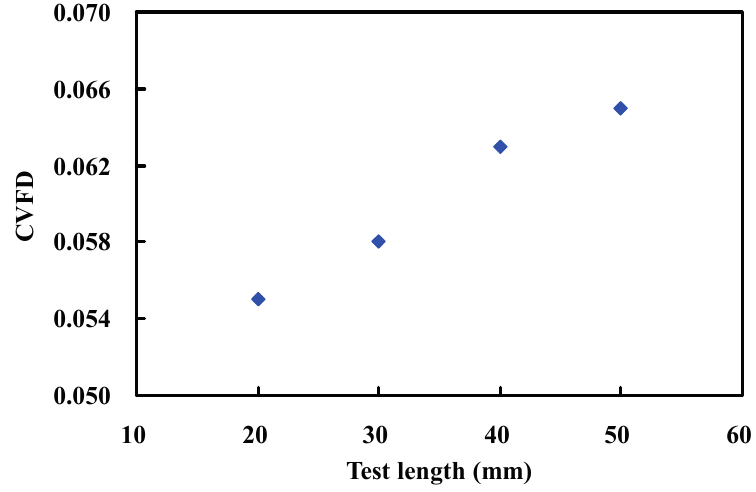
Figure 6. Coefficient of variations of fiber diameter as a function of test length.